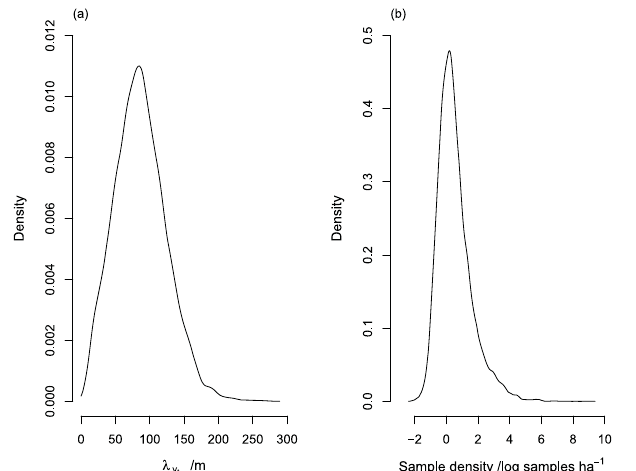
Figure 6. Empirical probability density function for grid spacing that achieves the target kriging variance (0.18) and corresponding PDF for the logarithm of the sample density which achieves the